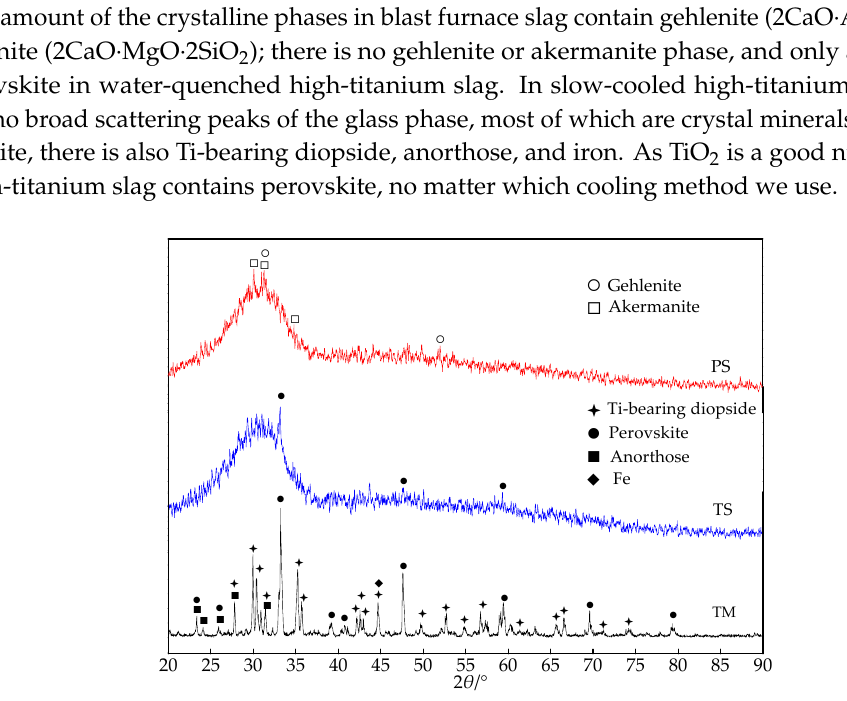
Figure 1. XRD patterns of three kinds of slag.